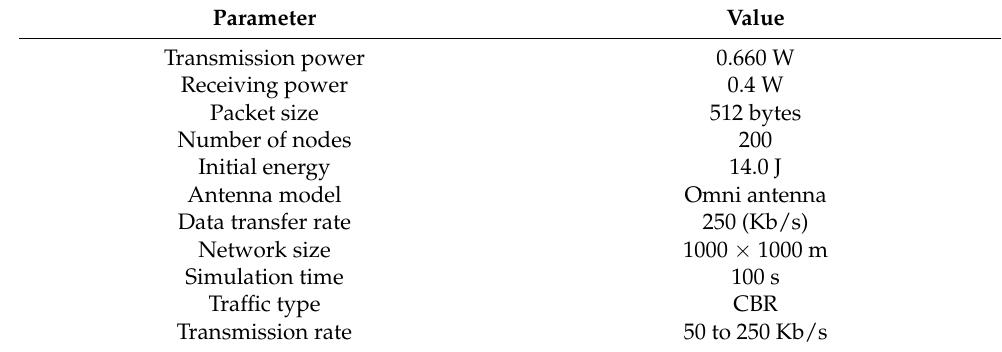
Table 1. Simulation specification.